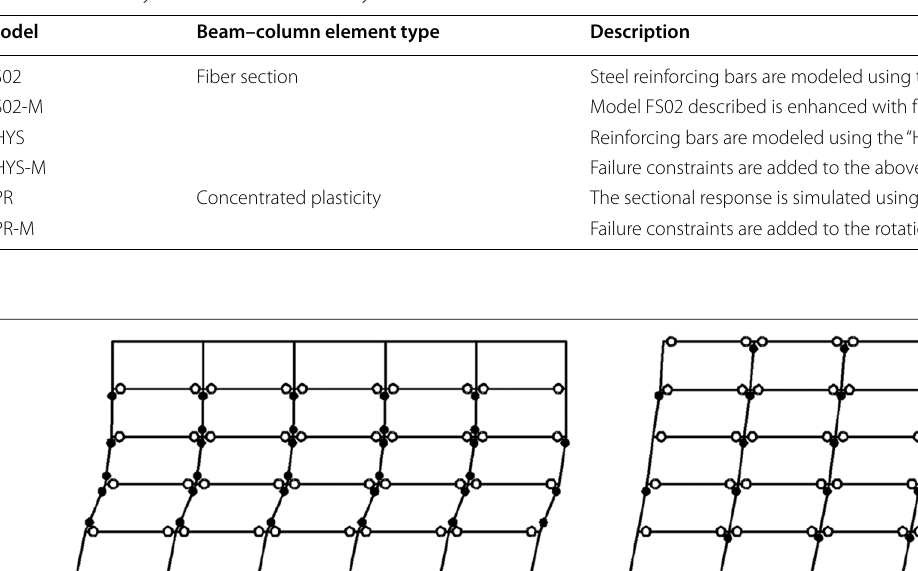
Table 2 Summary of models used in study.